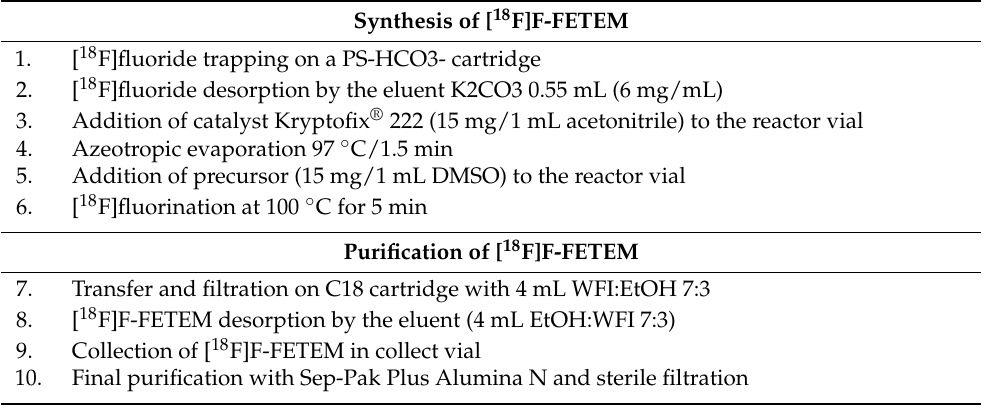
Table 3. Summary of the reaction sequence for [ 18 F]F-FETEM synthesis using GE Tracerlab FXFDG synthesis